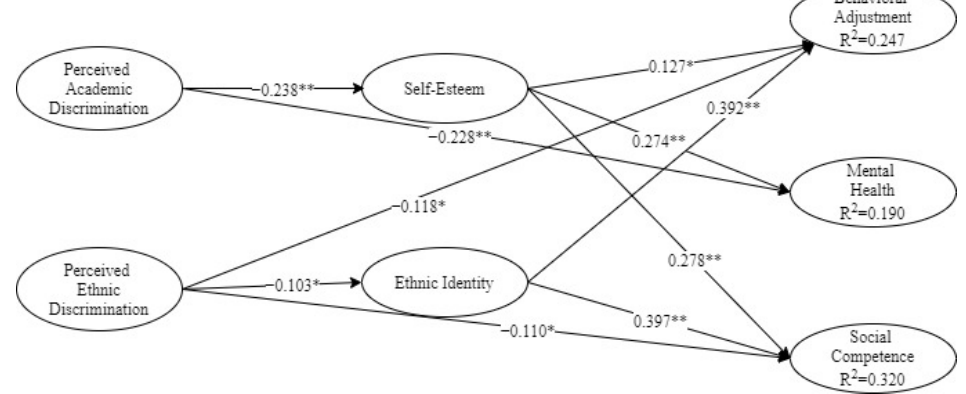
Figure 2. Standardised solutions for the structural model. Note. * p < 0.05, ** p < 0.01. Table 4. Standardised direct, indirect, and total effects.